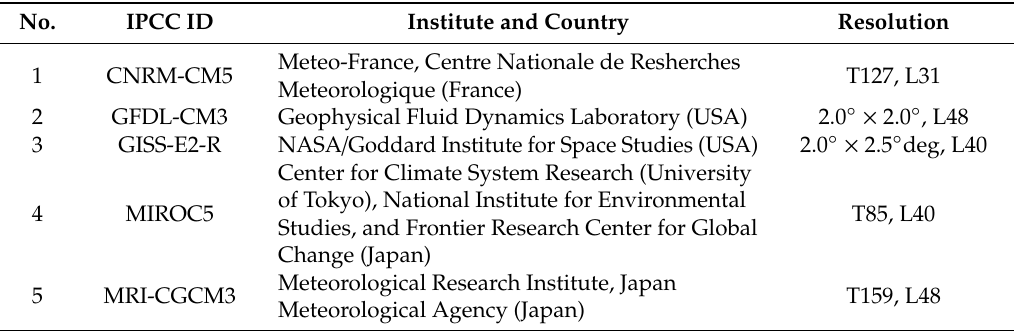
Table 1. List of Coupled Model Intercomparison Project Phase 5 (CMIP5) model output used in this